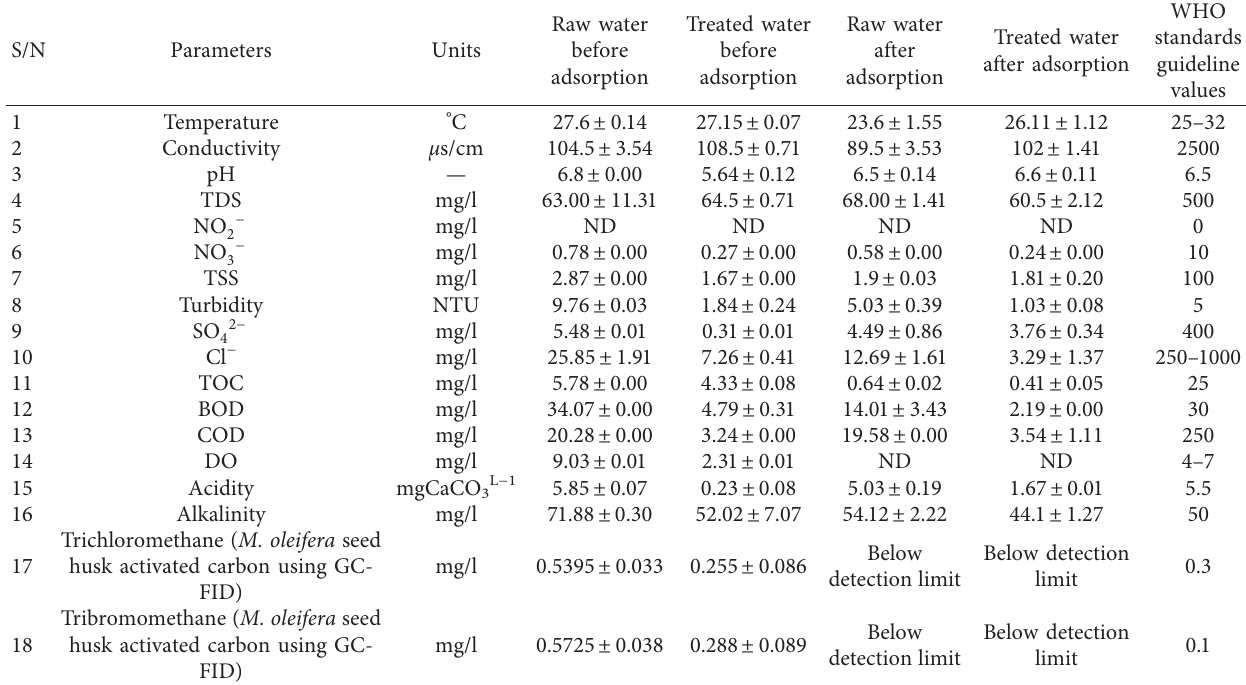
Table 1: Physicochemical analysis of influent raw and treated water before and after